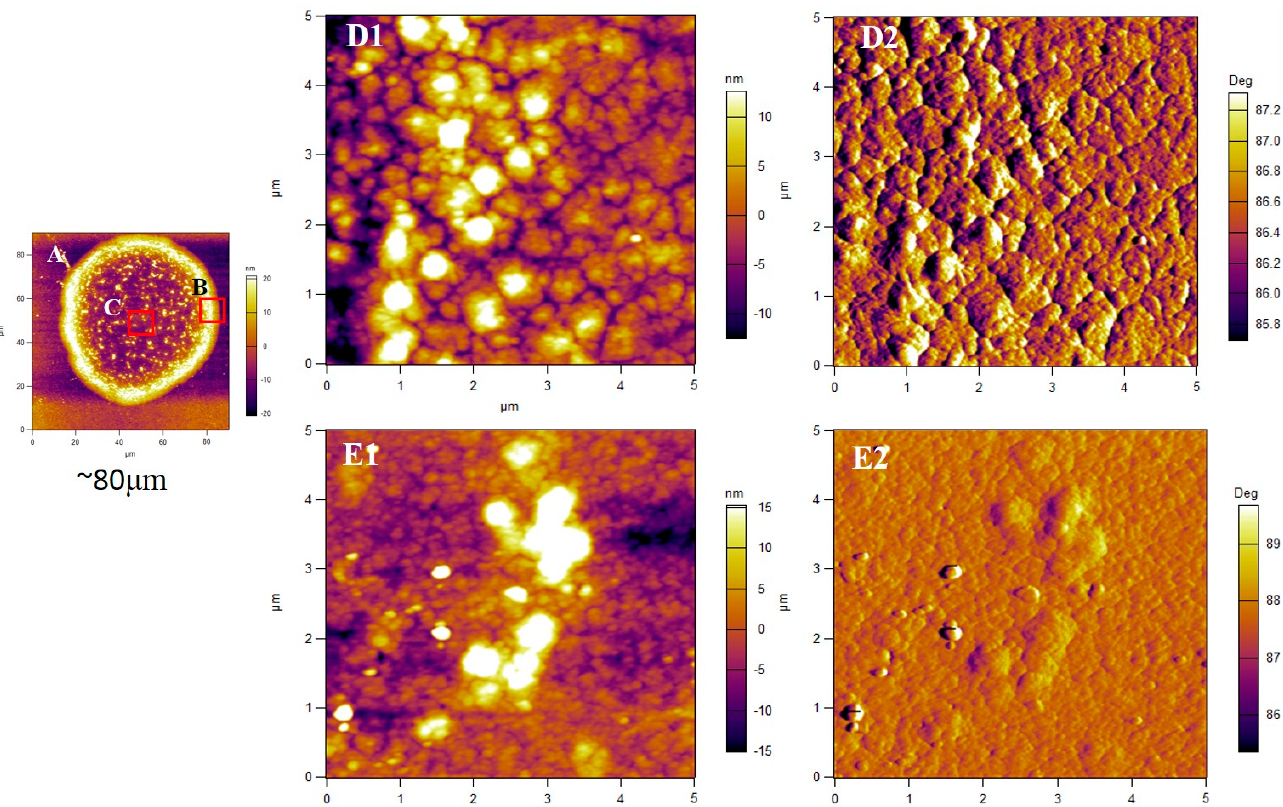
Figure 4. ( A ) AFM height image of dried PVDF/DMF solution droplet. ( B ) edge and ( C ) center regions of dried PVDF/DMF solution S ‐ droplet. ( D , E ) AFM images of edge and center regions in dried PVDF/DMF solution S ‐ droplet, respectively. ( 1 ) height image, ( 2 ) phase images, ( A ) 90 μ m × 90 μ m; ( D ) 5 μ m × 5 μ m; ( E ) 5 μ m × 5 μ m.